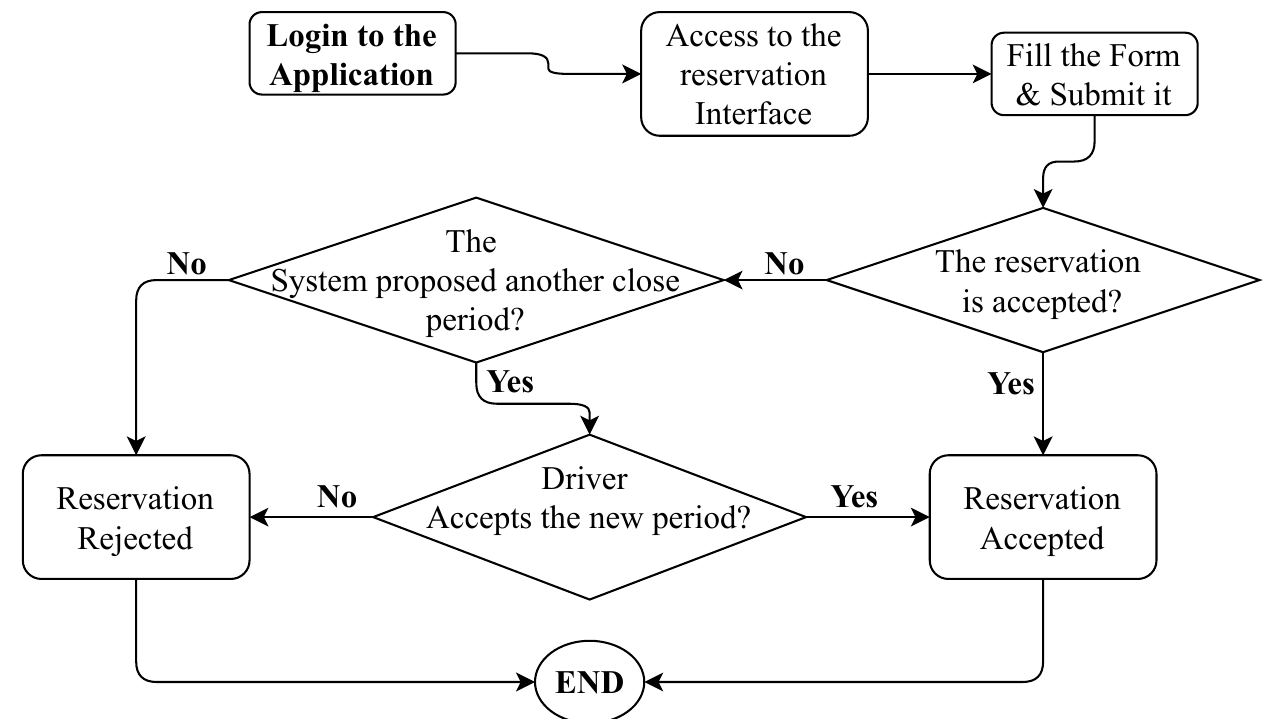
Figure 17. The reservation